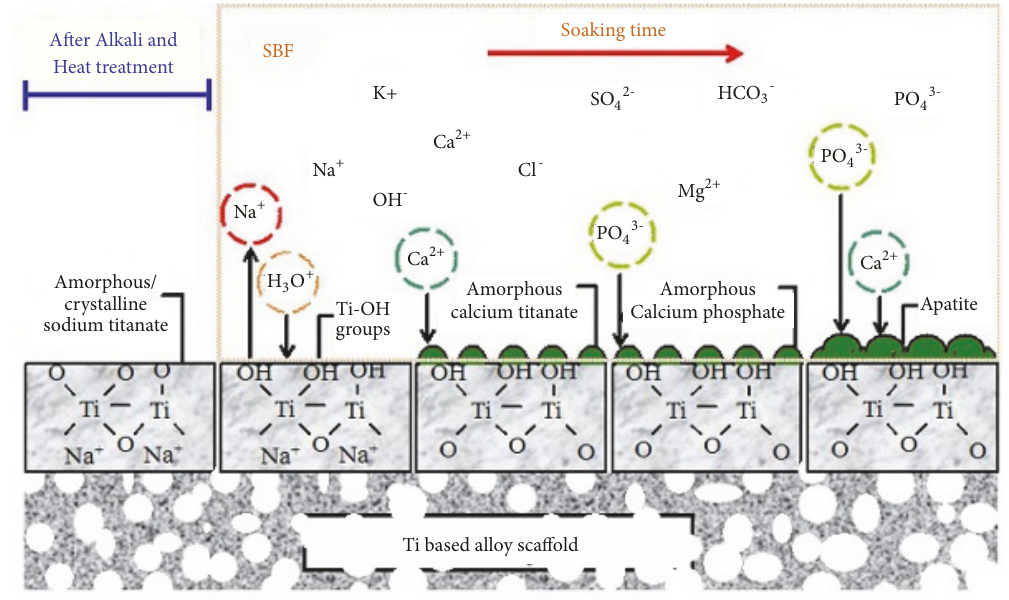
Figure 2: A schematic of apatite formation on the surface of alkali and heat-treated porous Ti based alloy scaffold soaking in SBF